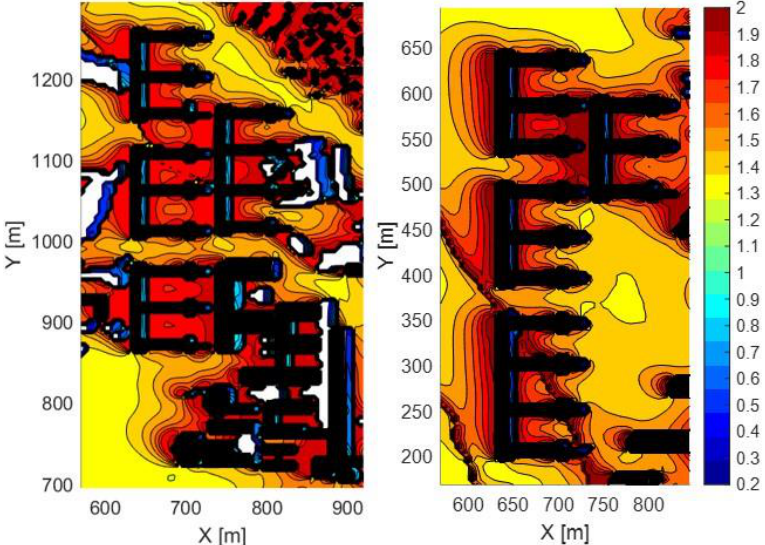
Figure 17. PMV (1.55 < PMV < 2.00) at pedestrian level: on the left, in the current situation; on the right, in the planned situation.